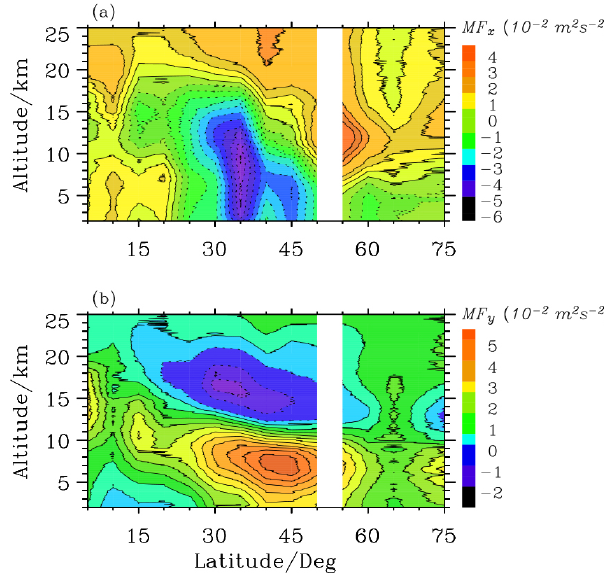
Figure 9. Latitudinal and vertical variations of averaged zonal (a) and meridional (b) momentum fluxes (in 10 − 2 m 2 s − 2 ) . The blanks denote no